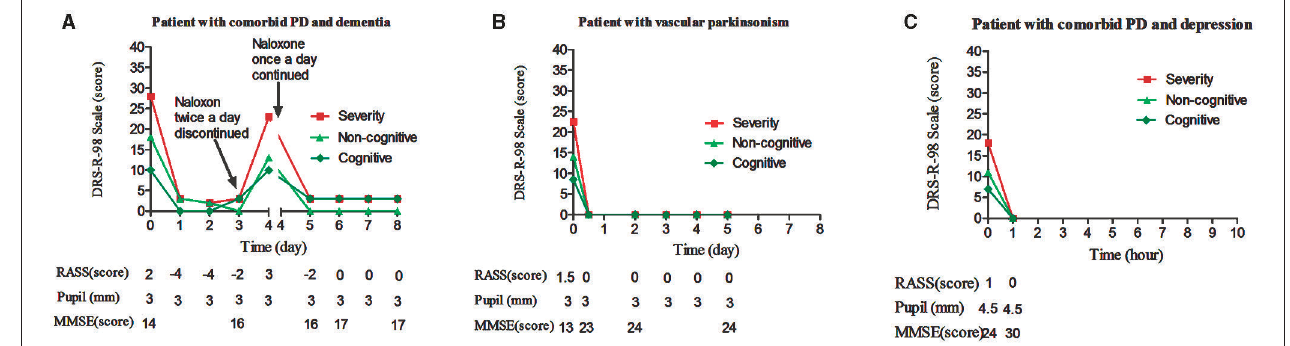
FIGURE 1 | Change in DRS-R98 scores over the study period, and corresponding measurements. (A) DRS-R98 severity and RASS scores decreased during each of the two treatment intervals. In the first, under twice-daily naloxone, the RASS was − 4, indicating the agitated patient was over sedated on days 1 and 2. The patient was delirium-free and mildly sedated on day 3 without naloxone treatment. On day 4, DRS-R98 severity and RASS scores were 23 and 3, respectively, indicating that delirium had returned. In the second interval, under nightly naloxone only, the patient was delirium-free and mildly sedated on day 5. MMSE scores were 14–16 and stabilized at 17 with remaining cognitive deficits. Corresponding pupil diameter was normal. (B) DRS-R98 severity and RASS scores decreased over time. A change in RASS score from 1.5 to 0 indicated that the mildly agitated patient became calm after sleeping 12h at night. The MMSE score increased from 13 to 23 and stabilized at 24 with remaining cognitive deficits. Corresponding pupil diameter was normal. (C) DRS-R98 severity and RASS scores decreased over time. RASS score of 1–0 indicated that the patient recovered from a restless to a normal state. The MMSE score increased from 24 to 30 indicating no cognitive deficits; however, pupil diameter remained 4.5mm (normally 3mm). DRS-R98, delirium rating scale-revised 98 (severity scale only; 13 items; maximum score, 39; delirium, > 15; resolution, < 12); MMSE, mini mental status examination (30 point cognitive test; maximum score 30); RASS, Richmond agitation sedation scale (10 levels; 4, combative; 3,